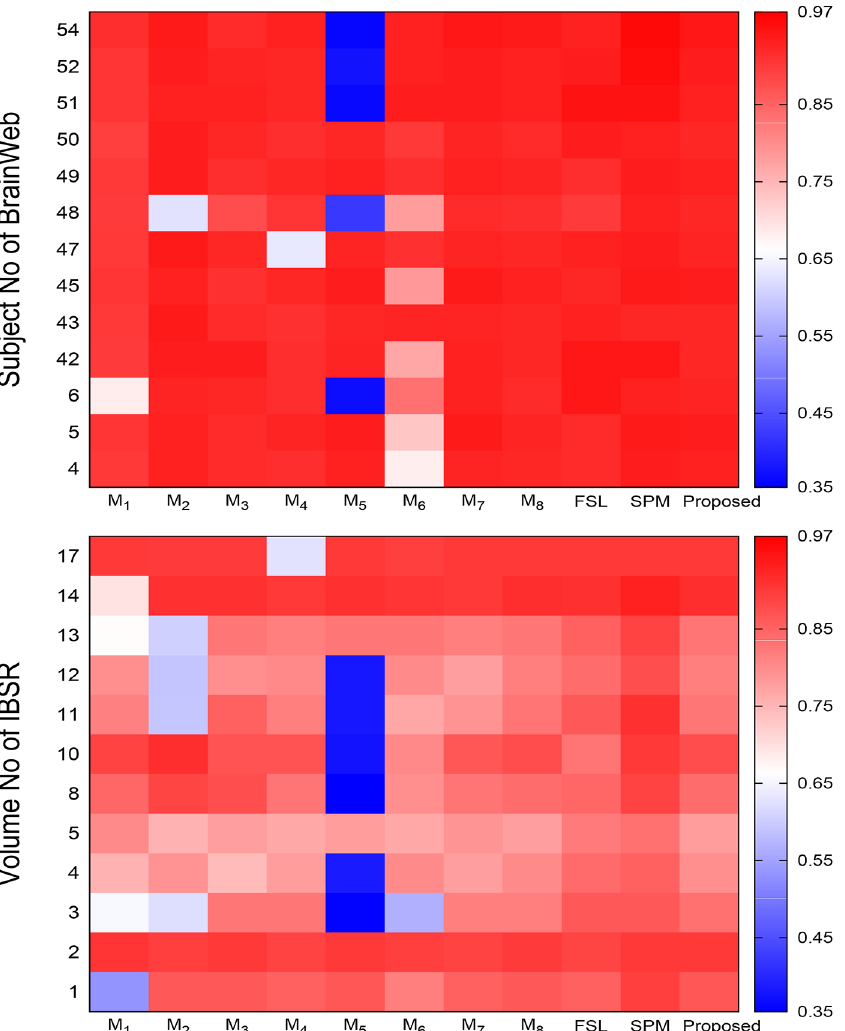
Fig 10. Heat maps obtained by different methods with respect to sensitivity.